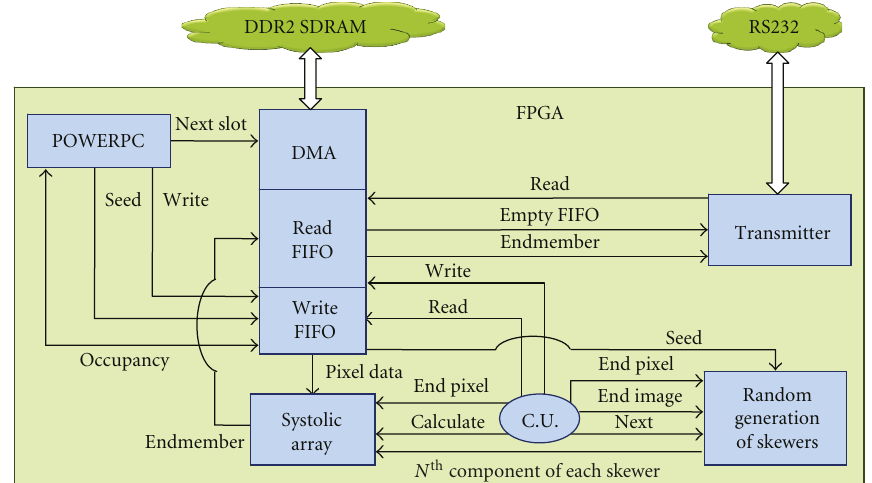
Figure 6: Hardware architecture adopted for implementation of the PPI